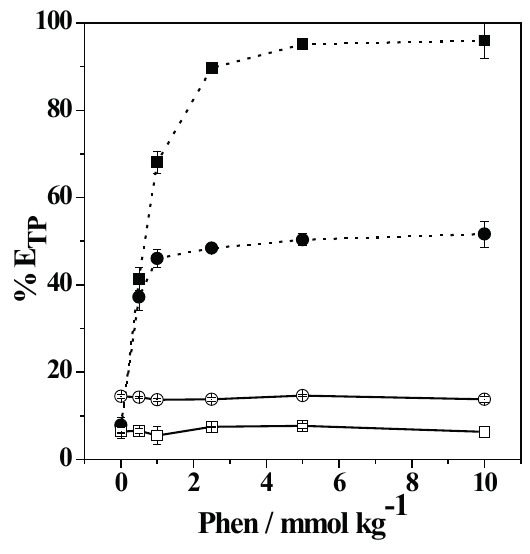
Figure 3 - Effect of macromolecule nature and 1,10-phenatroline (phen) quantity added in the ATPS on the %E TP of iron species: ( (cid:4) ) Fe(II) and ( (cid:3) ) Fe(III) at PEO1500+Na 3 C 6 H 5 O 7 + H 2 OATPS; Fe(II) ( • ) and Fe(III) ( ◦ ) at L64+Na 3 C 6 H 5 O 7 +H 2 O ATPS; [iron]=0.100 mmol kg -1 ; pH = 6.00; T=25.0 °C;